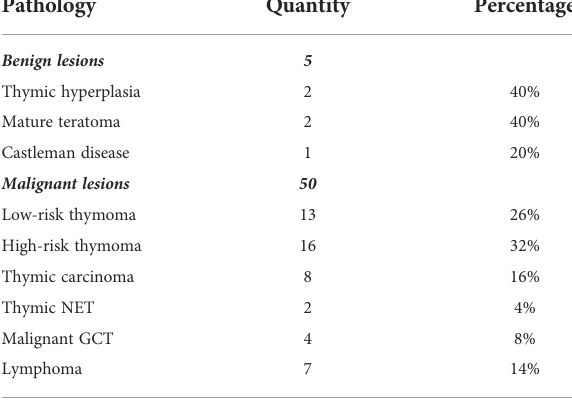
TABLE 1 Pathological diagnoses.